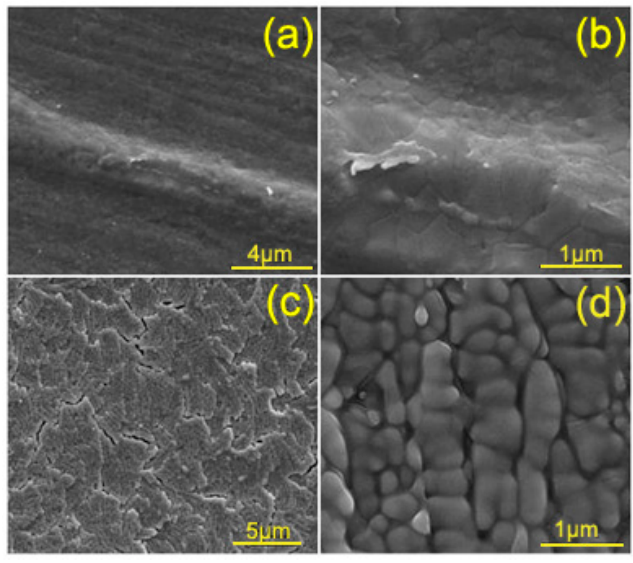
Figure 2. SEM images of Cu–Te alloy ribbons after MS; ( a ) free surface, low magnification; ( b ) free surface, high magnification; ( c ) contact surface, low magnification; and ( d ) contact surface, high magnification.